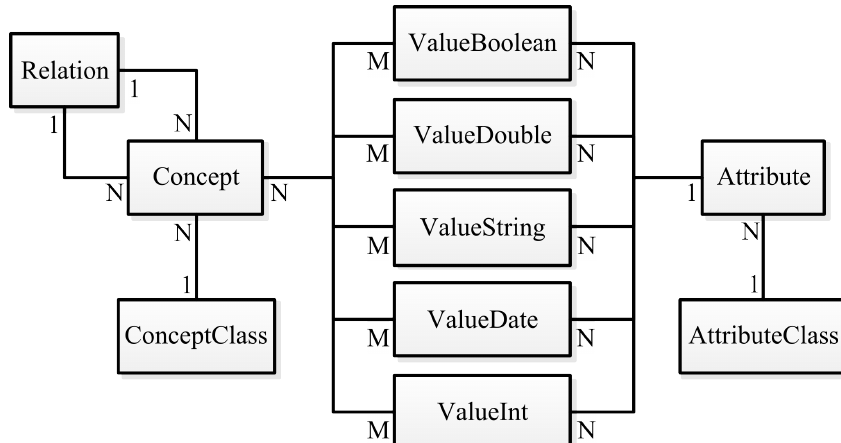
Figure 2: Overview of the generalized data structure (ontology) component. The central entity of this component Concept is associated to combinations of Attribute and value entities. In addition, a Relation is used to associate Concept entities to each